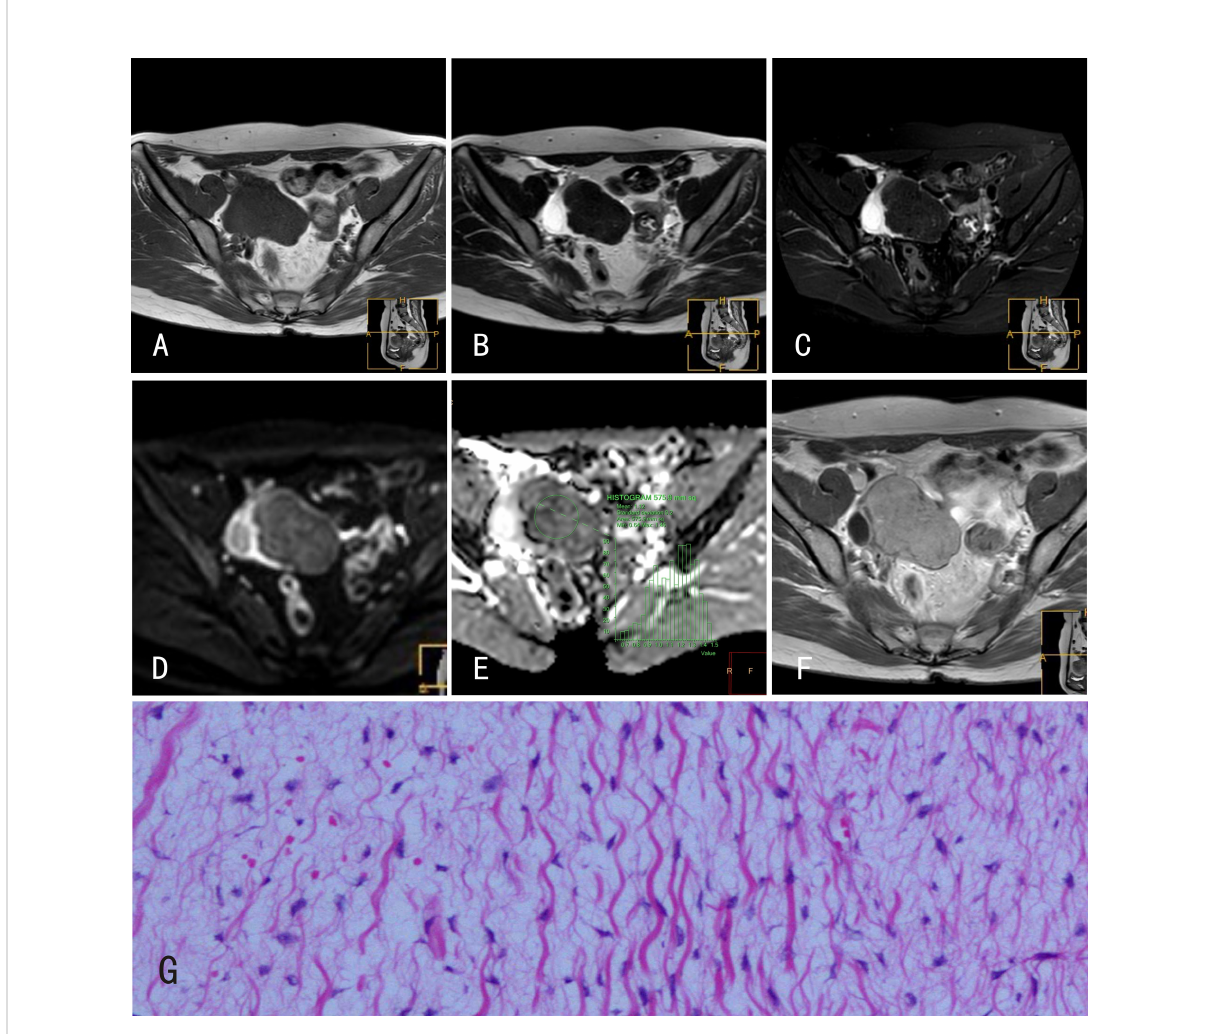
FIGURE 2 Ovarian fi bromas. 22-year-old female with a right ovarian fi broma. (A) The ovarian fi broma showed an isointense signal on mDIXON-T1WI; (B) isointense signal on TSE-T2WI; (C) isointense signal on TSE-T2WI-SPIR; (D) hyperintense signal on DWI (b=800s/mm 2 ); and (E) isointense signal on the ADC map. (F) The ovarian fi broma was markedly enhanced after Gd-DTPA administration. (G) Histological features of ovarian fi bromas, HE×100, tumor cells are spindle shaped and loosely arranged such that they appear as “ tadpoles ” surrounded by signi fi cant interstitial